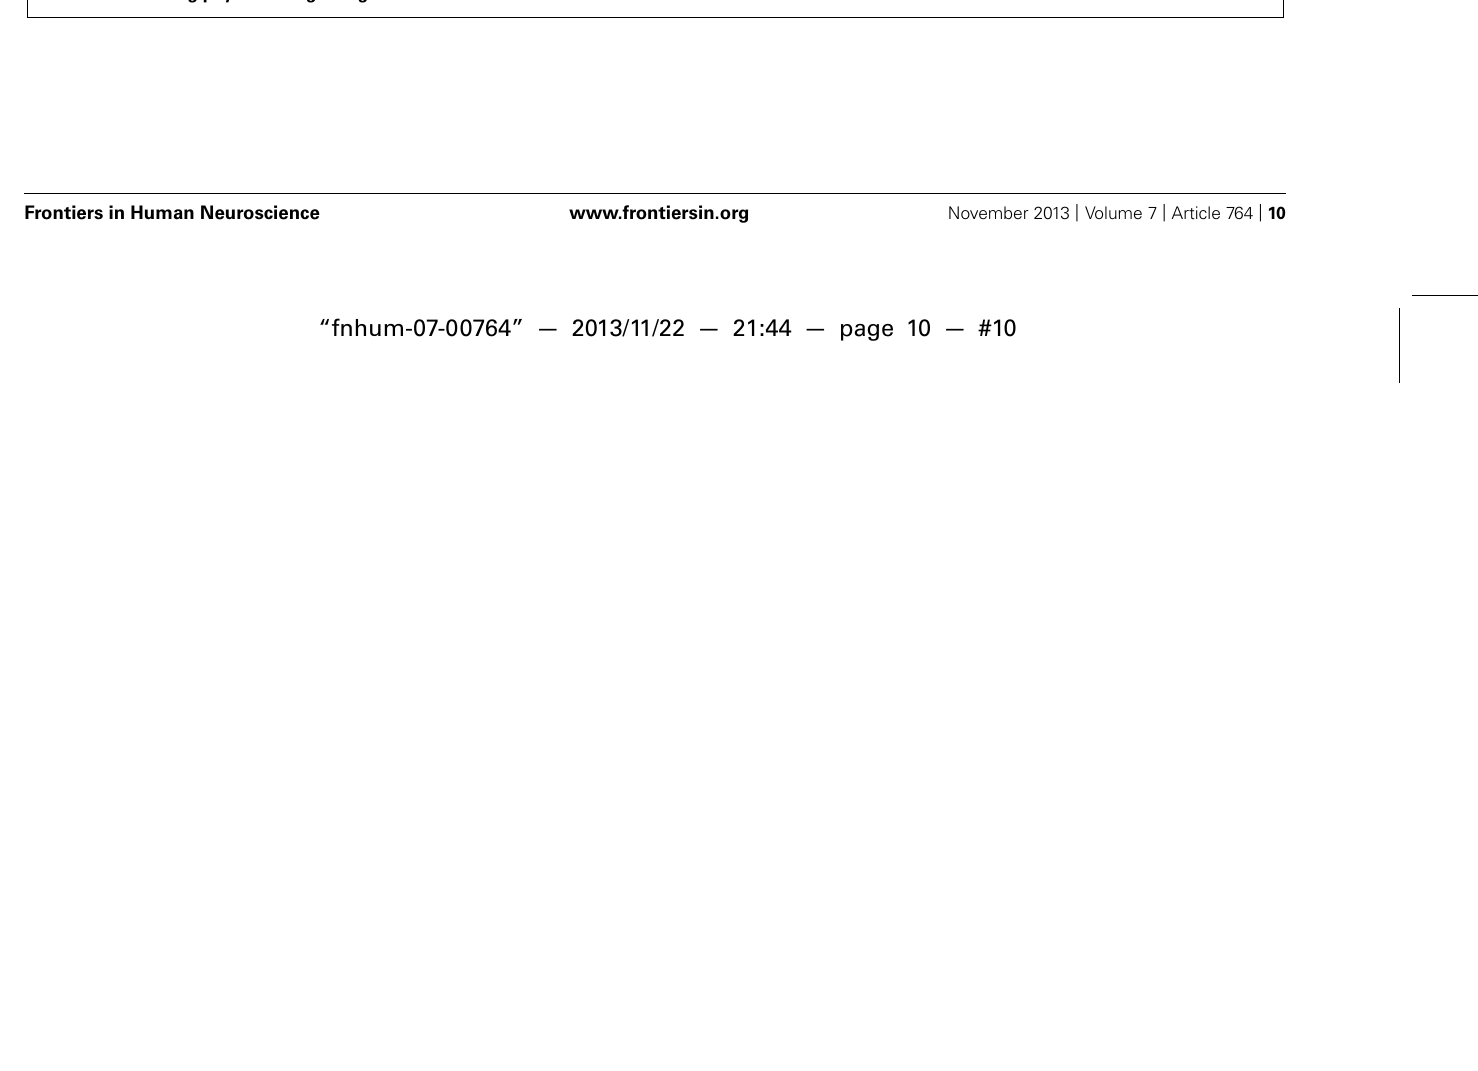
FIGURE 3 | Social evaluation vs. physical danger contrast, with regions reliably more active during social evaluation in orange and regions reliably more active during physical danger in green.